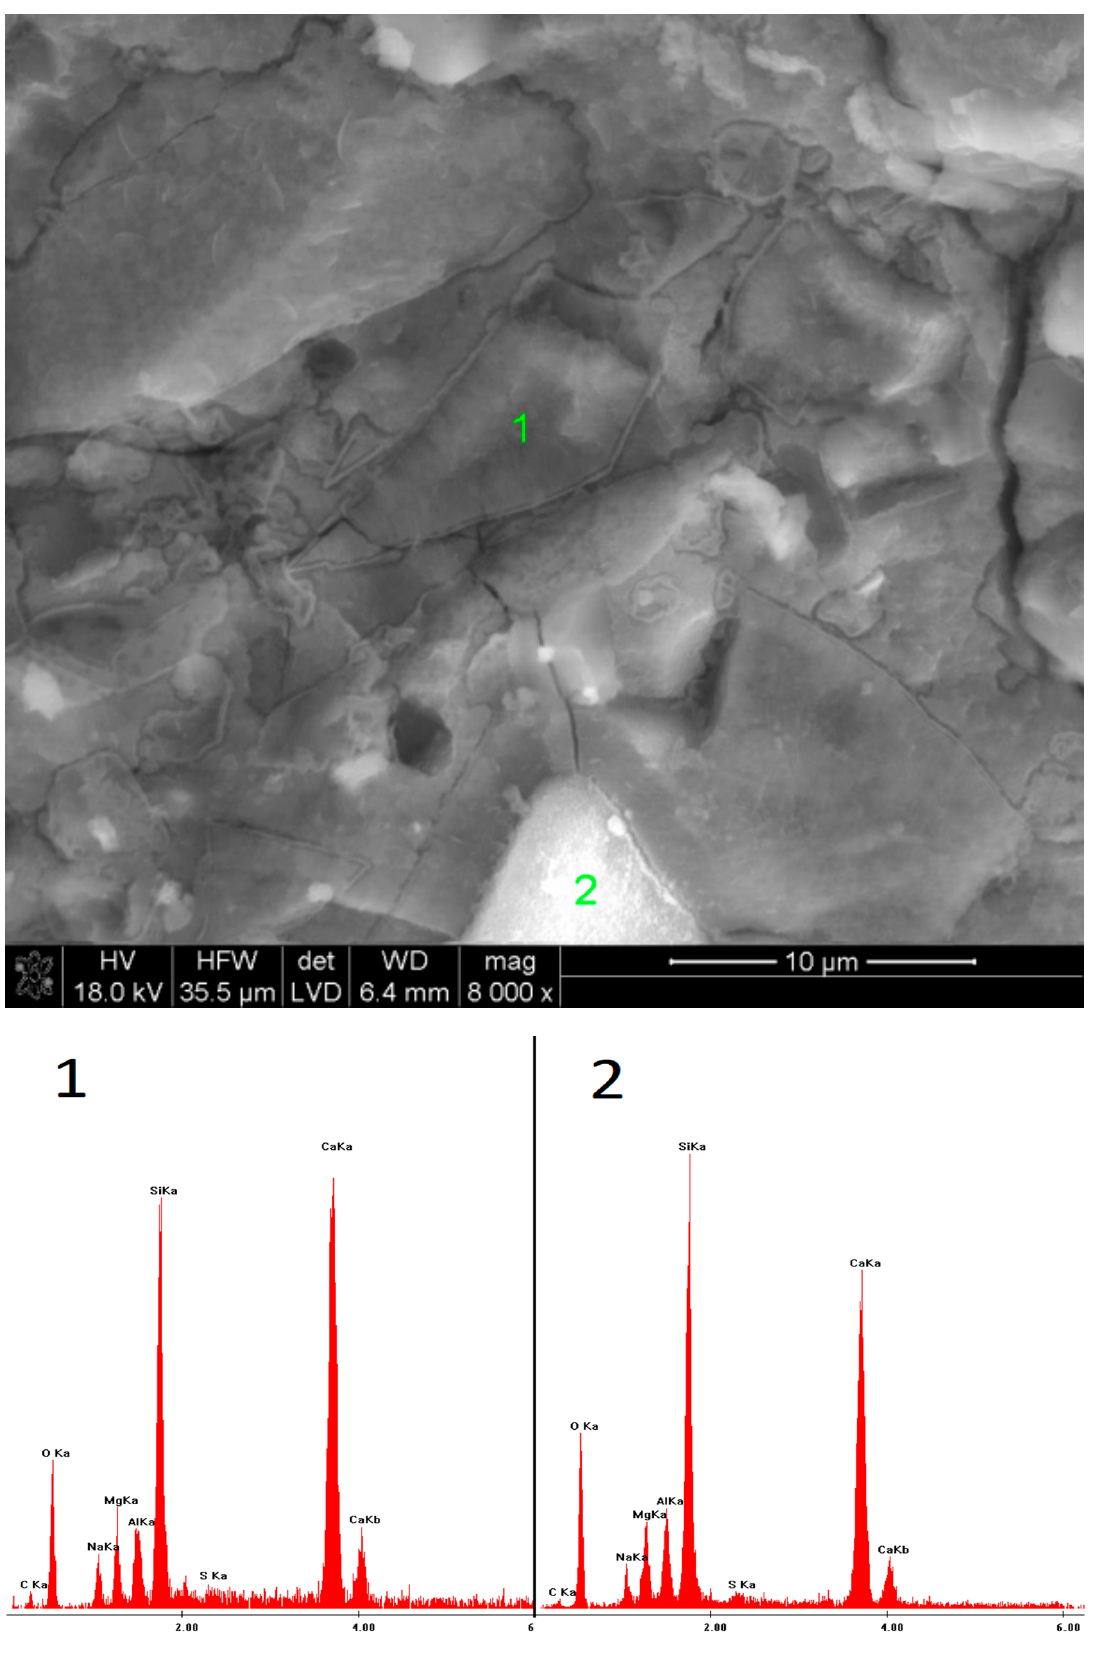
Figure 11. Microstructure of slag paste activated with sodium carbonate after 40 days of curing—SEM + EDS; 1 , 2 —slag grains covered with hydration products.